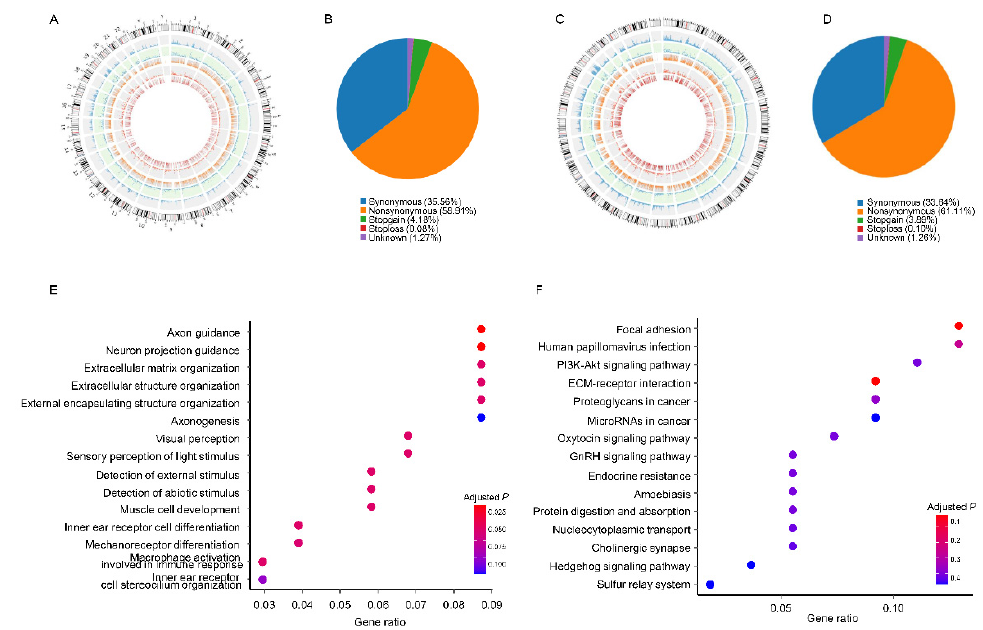
Figure 3. Mutation of circulating tumor cells detected by next-generation sequencing. For patient 1: ( A ) The overview of the somatic mutational profiles of CTCs. Chromosomes are presented in the outermost circle clockwise. The blue histograms indicate the log-transformed sequencing depth, setting 1 Mbp as a unit. The blue points show the number of SNPs in each chromosome. The following orange histograms suggest the relative proportion of homologous SNPs; the grey area in this ring refers to heterozygous SNPs. The red points stand for the number of indel mutations in each chromosome. The innermost circle shows the proportion of homologous or heterozygous indel mutations; red histograms refer to homologous mutations and the grey area refers to heterozygous mutations. ( B ) The distribution of CTC mutations. For patient 2. ( C ) The overview of the somatic mutational profiles of CTCs. ( D ) The distribution of CTC mutations. ( E ) Gene ontology biological process, and ( F ) KEGG pathway enrichment analysis in circulating tumor cells. Abbreviation: